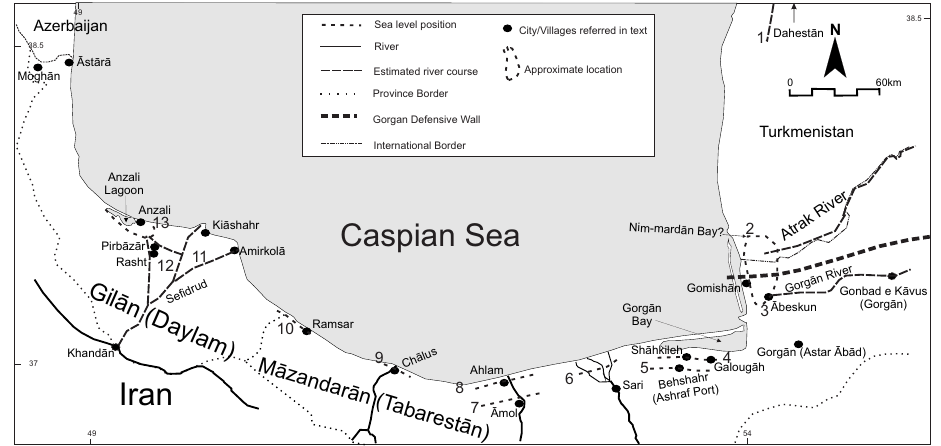
Fig. 8. The Iranian Caspian coast and reported historical observations. The ancient names are denoted in parentheses: (1) the possible position of sea level in Dahest¯an in the second half of the tenth century (al-Istakhri, 1961, 1973; Barthold, 1984; Ibn Hawqal, 1988). (2) The probable position of Nim-mard¯an Bay (Mostowfi, 1999; Kakroodi et al., 2012). (3) The probable position of ¯Abeskun along the Caspian shoreline (Jovayni, 1911; al-Istakhri, 1961; Ibn Hawqal, 1988; Mostowfi, 1999; al-Mas’¯ud¯ı, 2012). (4) The sea-level position in 1906 in Galoug¯ah (Rabino, 1980). (5) The position of Ashraf port in 1628 (Parodi, 1997). (6) Uzbeks shipped the captives of M¯azandar¯an from S¯ari (Mostowfi, 1999). (7) Sea-level position in Ahlam in the ninth century (al-Ya’q¯ub¯ı, 1968). (8) Sea-level position in Ahlam reported by Ibn Hawqal (1988), Mostowfi (1999) and Mar’ashi (1982). (9) Sea-level position in Ch¯alus reported by Ibn Hawqal (1988) and Jayh¯ani (1989) in the tenth century. (10) Sea-level position in an area between Daylam and M¯azandar¯an in the tenth century (Ibn Hawqal, 1988; Jayh¯ani, 1989). (11) The Sefidrud or its tributary course in the tenth century (Hudud al-‘Alam, 1973). (12) The main course of Sefidrud and its tributary in the eighteenth and nineteenth centuries (Rabino, 1917; Barthold, 1984; Farh¯ad Mirz¯a, 1987). (13) The Anzali Spit broke into barrier islands in the fifteenth century (Mar’ashi,